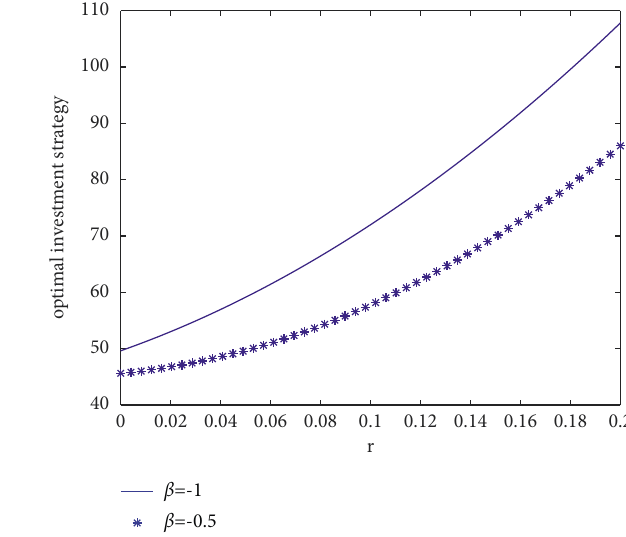
Figure 5: Influence of β on optimal investment ratio π ∗